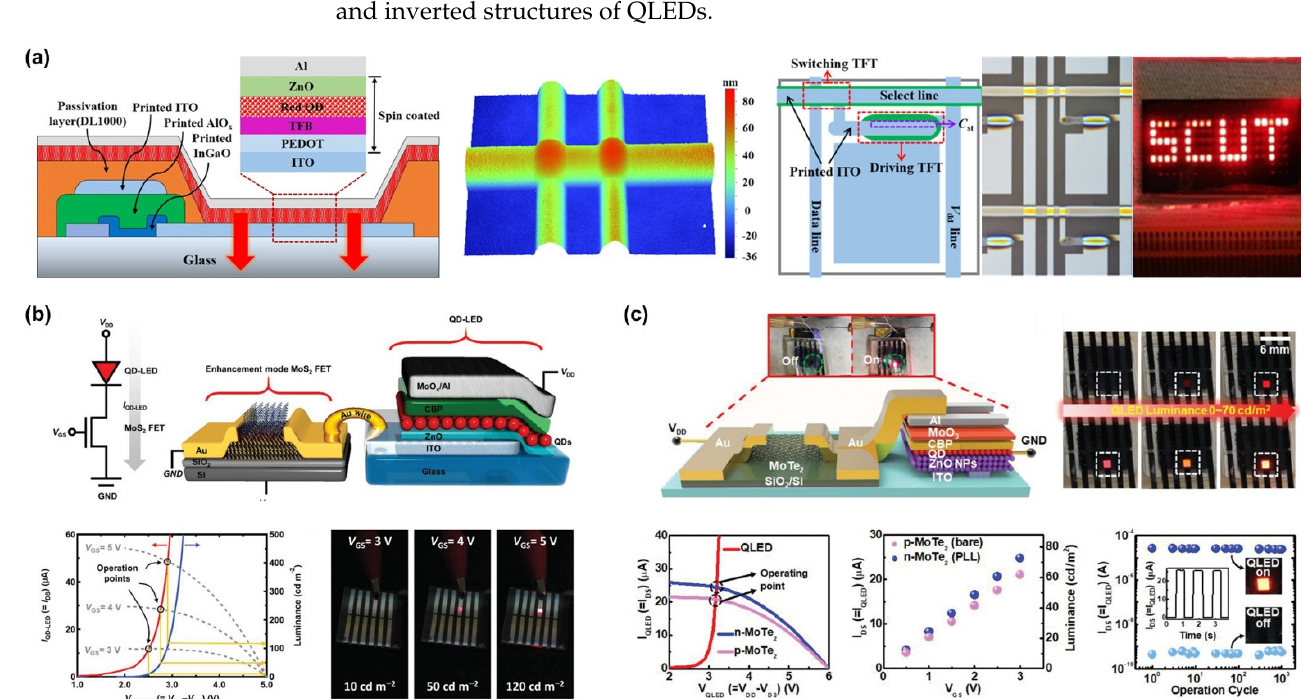
Figure 6. Monolithically integrated TFT–QLED devices: ( a ) Schematic cross-sectional diagram of inkjet-printed TFT–QLED pixel, the morphology of the inkjet-printed oxide film, the pixel structure, and a demonstration of the 2T1C-structured AM-QLED (Reproduced from [24] with permission from American Chemical Society). ( b ) Schemes of TFT–QLED using the multilayered MoS 2 TFT with ODTS-SAM on the back channel, current–voltage characteristics along with the driving current level, and luminance change (Reproduced from [23] with permission from Wiley). ( c ) Schematic structure of MoTe 2 TFT-driven QLED with luminance changes, current–voltage characteristics of type-converted TFTs via PLL treatment, current–voltage–luminance characteristics of the TFT– QLED device, and their stability (Reproduced from [25] with permission from Wiley).